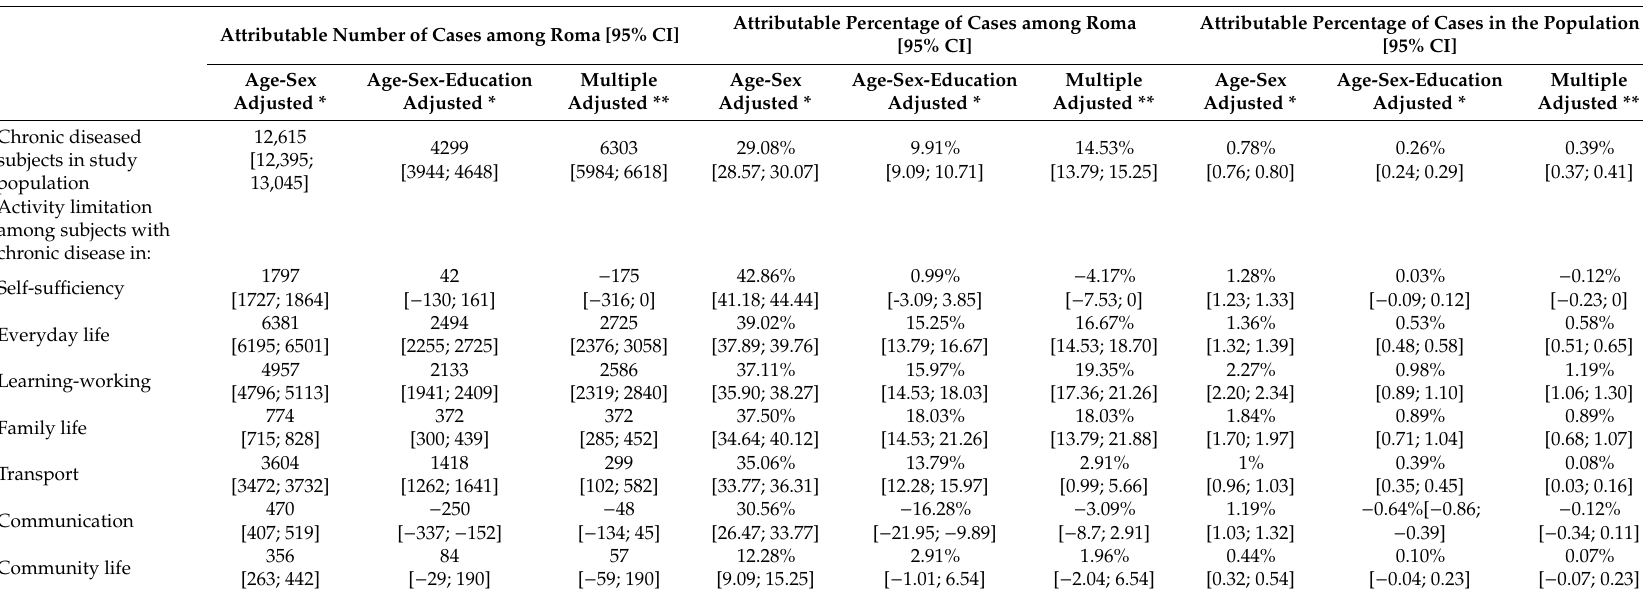
Table 4. Roma ethnicity’s association with the occurrence of having at least one chronic disease and activity limitations among those with chronic disease, according to age- and sex-standardized risk ratios (RR); age-, sex-, and education-standardized risk ratios (RR e ); and multivariate logistic regression analyses